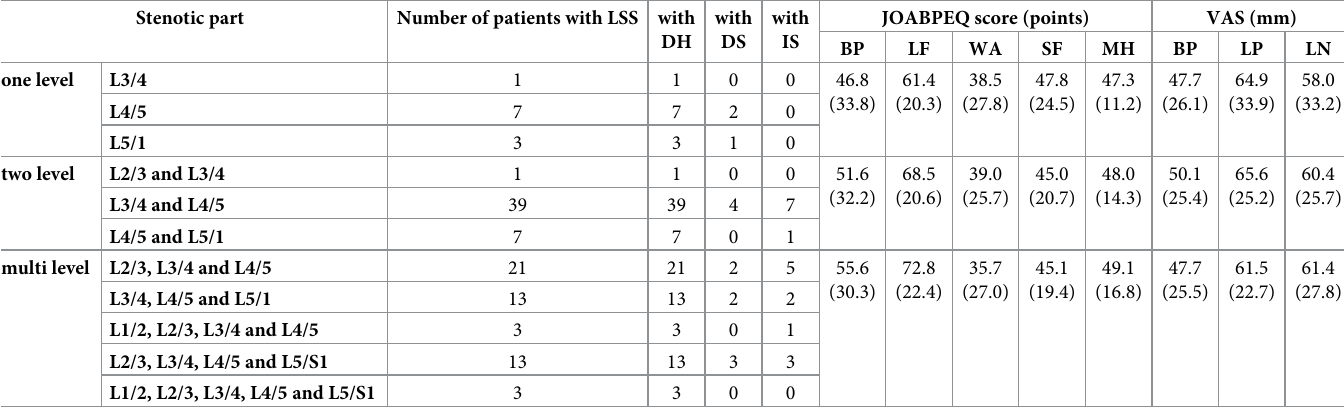
Table 1. Patients’ clinical characteristics.